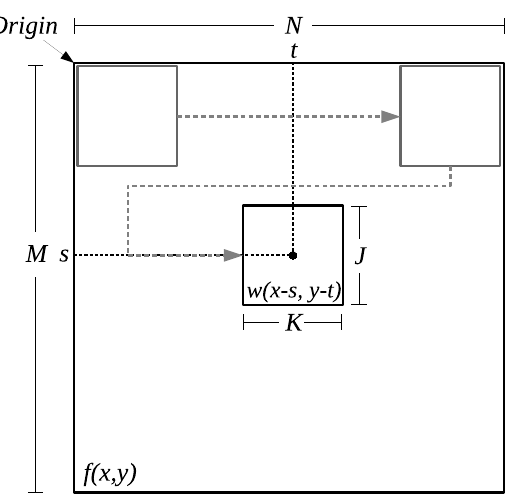
Figure 9. Reference f and template window w